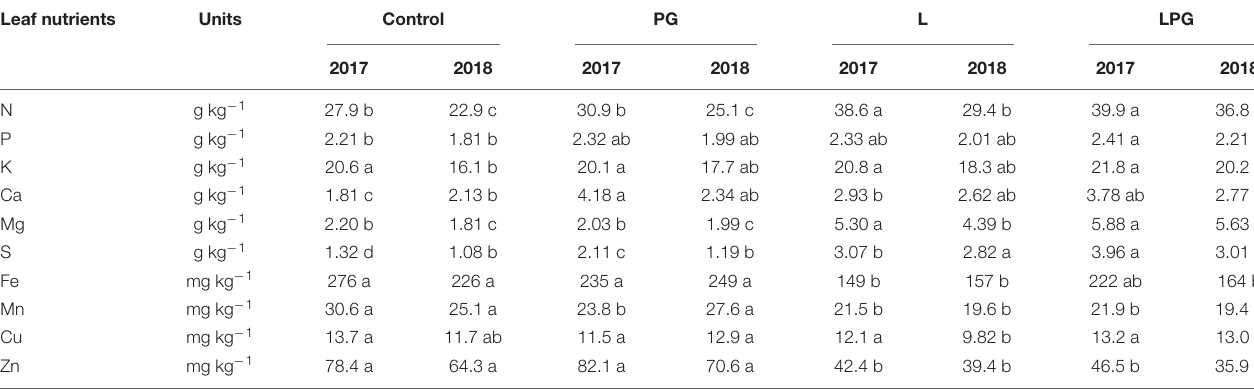
TABLE 1 | Influence of surface-applied lime (L), phosphogypsum (PG), and lime + phosphogypsum (LPG) on nutrient (N, P, K, Ca, Mg, S, Fe, Mn, Cu, and Zn) concentrations in the leaves of maize cultivated in two growing seasons in a long-term no-till system. Leaf nutrients Units Control PG